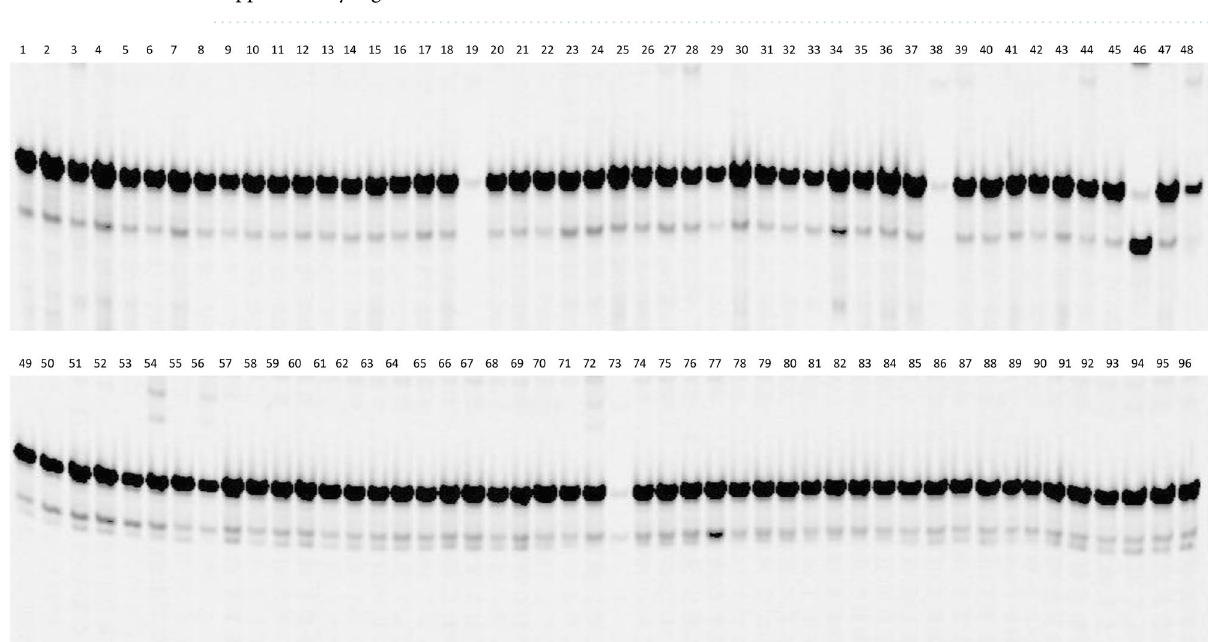
Figure 6. Cropped gel image from PCR amplification of SNP marker C13_181792157 diagnostic for R 11 on a panel of 96 diversified sunflower lines. Lane 23 is RHA 340 with R adv ; and lane 46 is HA-R9 carrying Rf5 and R 11 (Supplementary Table S1) . Bottom diagnostic bands were 115 and 120 bp in length including 21/26 bp tail primer, respectively. Full-length gels are presented in Supplementary Figure